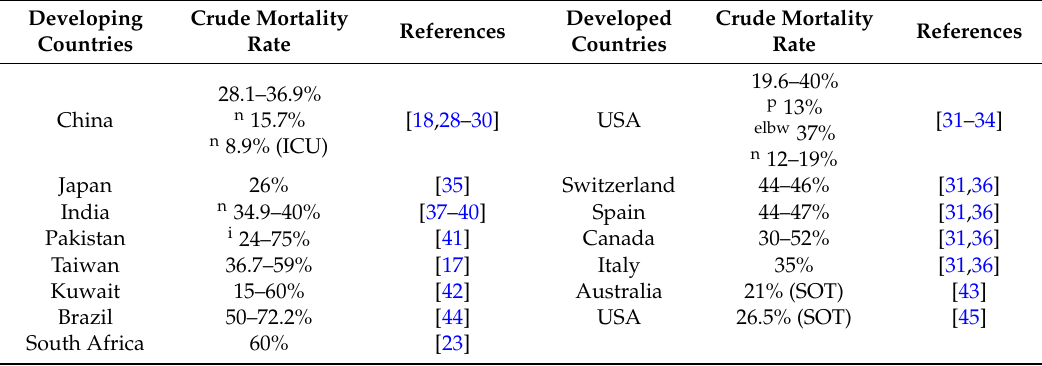
Table 2. Country-wise mortality rates due to candidemia.